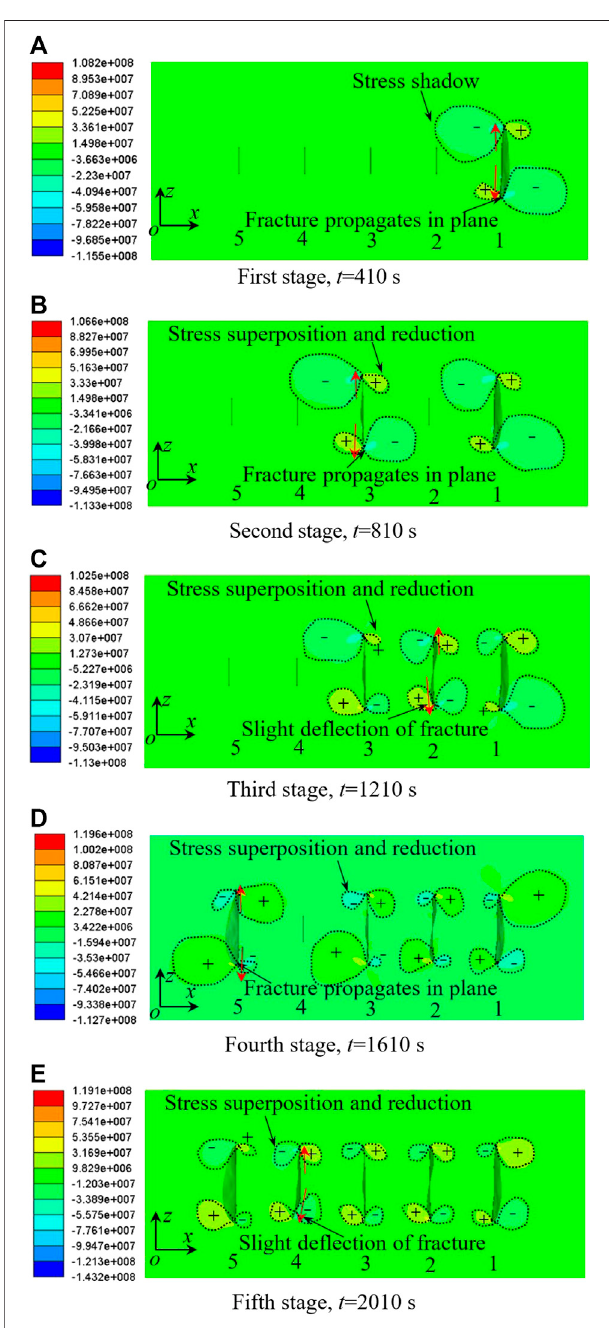
Figure 6 . The upper left side of the fracture is positive shear stress and the right side is negative shear stress. At the same time, the shear stress is negative at lower left of the fracture, andshear stress is positive at the lower right of the fracture. By comparing Figures 6A,B , it is found that the induced shear stress fi eld area around the fracture is larger when the thermal effect is considered, and the shear stress disturbance caused by the reduction of induced shear stress superposition is stronger.